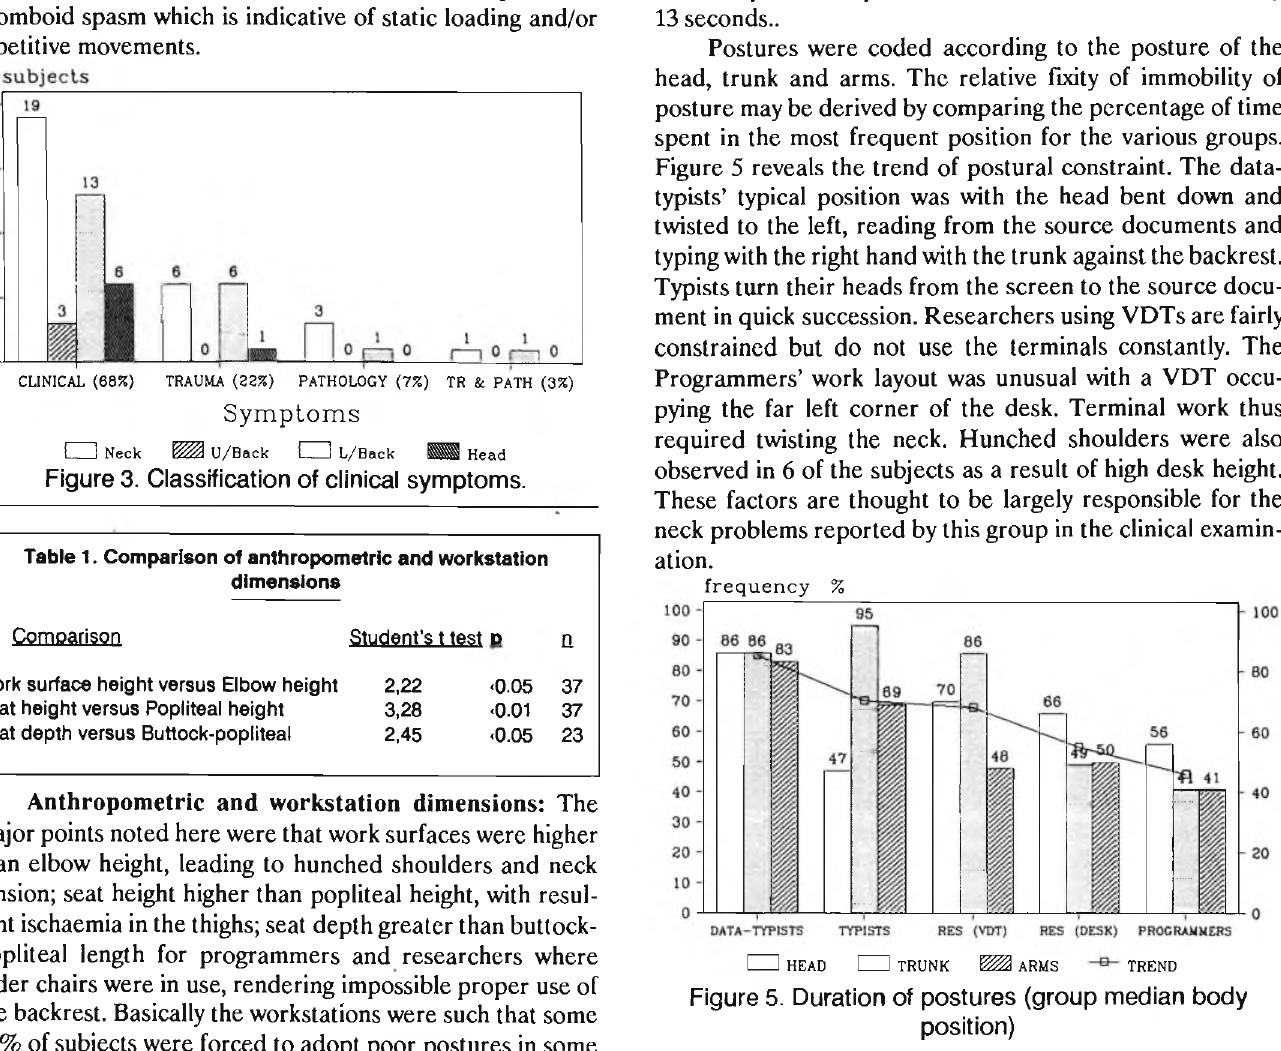
Figure 5. Duration of postures (group median body